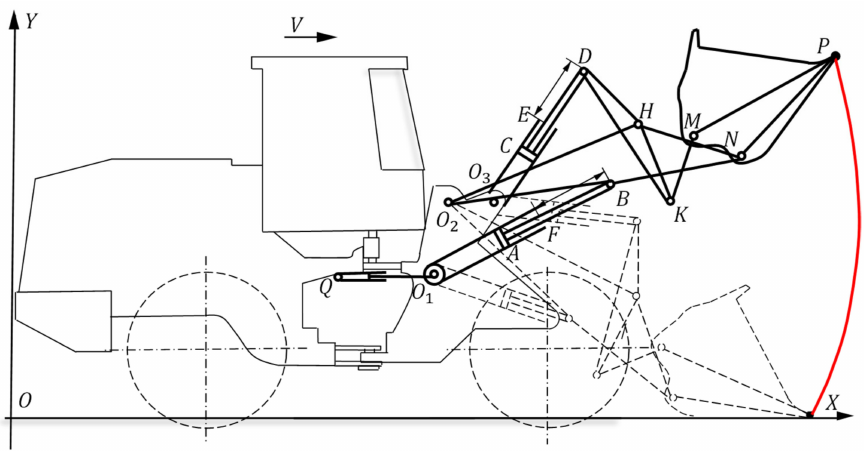
Figure 1. Working trajectory diagram of the loader’s shoveling